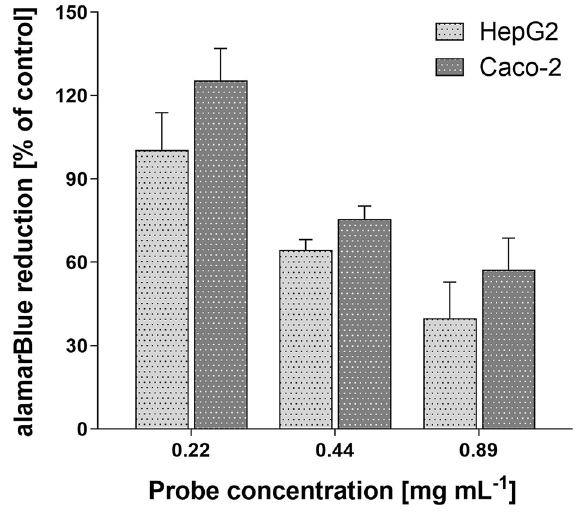
Figure 4. Results of alamarBlue cell viability assay, represented as a percentage of the resazurin reduction by HepG2 and Caco-2 cells comparing to the control cells after a 24-h incubation with the 2.04 mmol L −1 Fe 3+ probe with the calcium phytate concentration of 0.22–0.89 mg mL −1